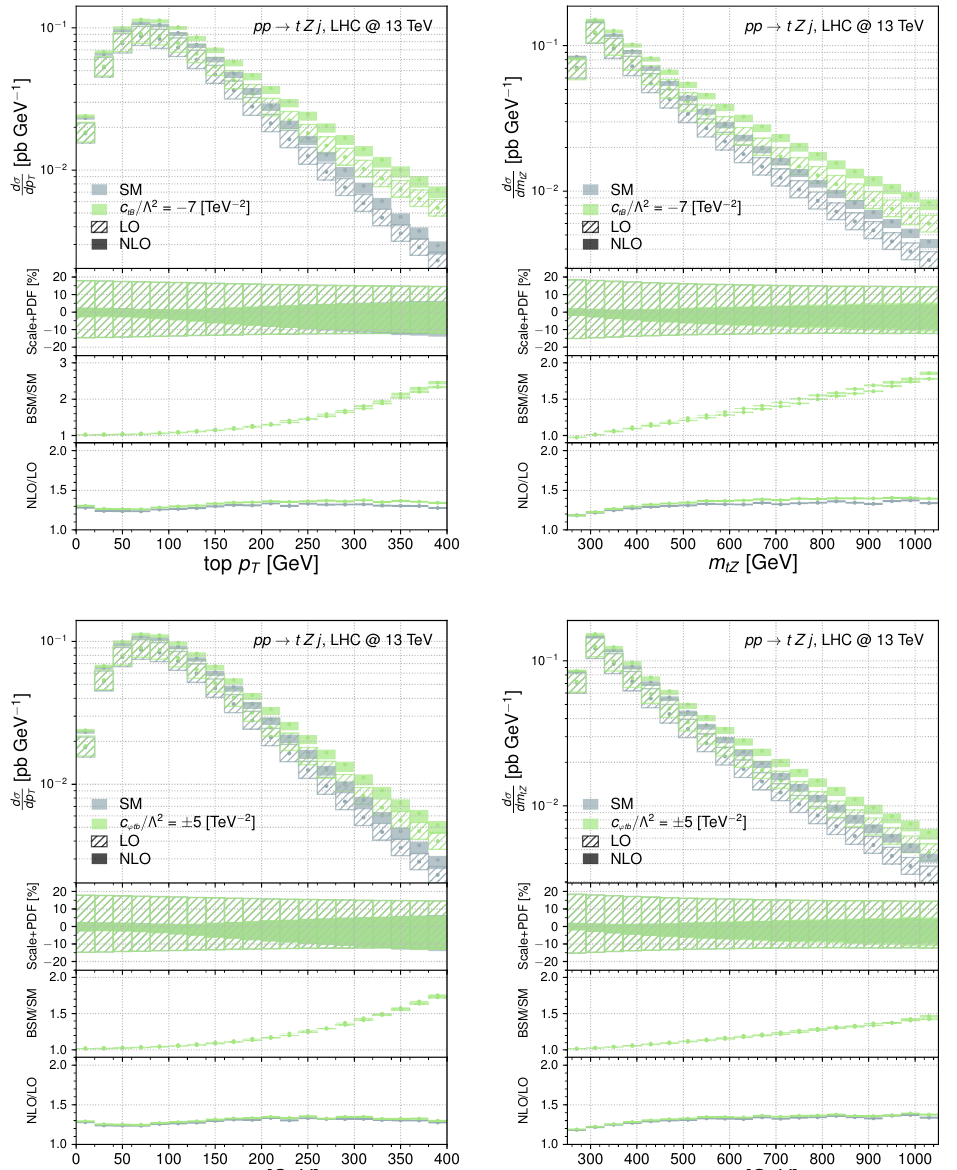
Figure 5 . Di(cid:11)erential distributions of the top p and top- Z system invariant mass for the tZj T process for given values of the and operator coe(cid:14)cients roughly saturating current indi- O tB O ’tb vidual, direct limits. The lower insets show the scale and PDF uncertainty bands, the ratio over the SM prediction and (cid:12)nally the corresponding K